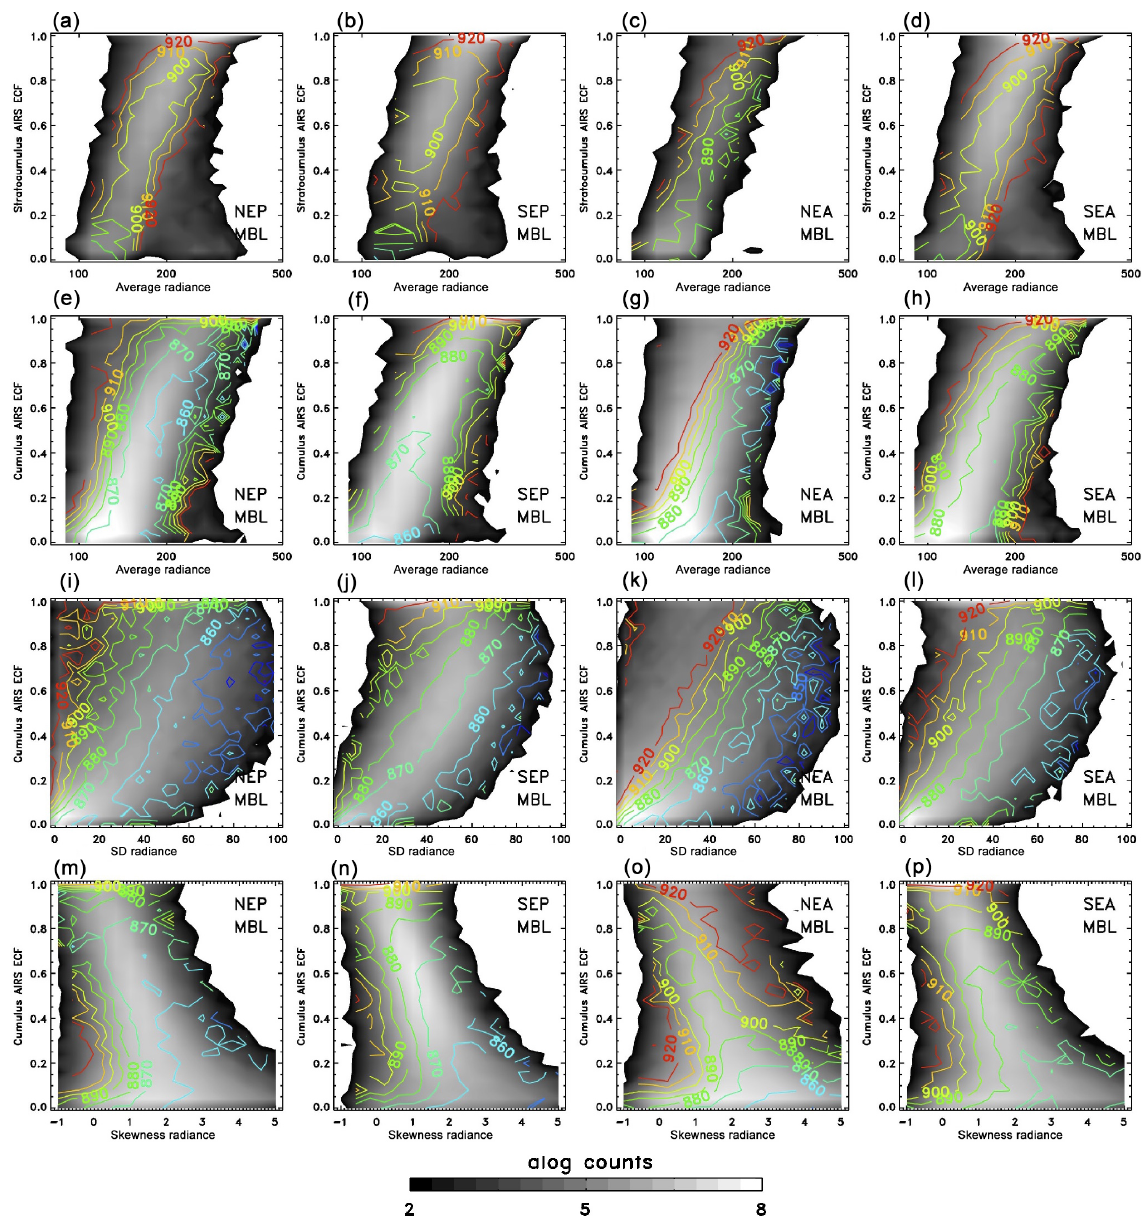
Figure 8. Joint PDFs of visible radiance versus ECF for the four spatial regions listed in Table 1. The SEP in Fig. 7 is repeated here for